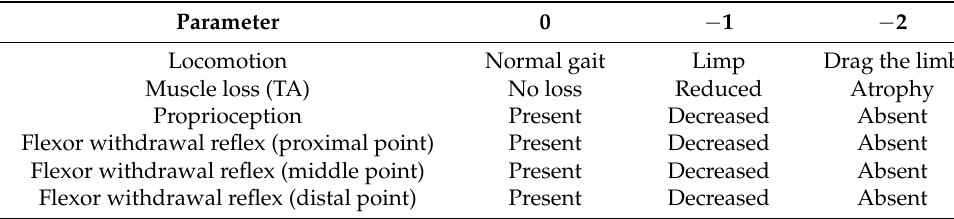
Table 1. Items used in the functional evaluation of sheep after injury and repair of the peroneal nerve. The score points negative values in the case of deficit or loss of response.